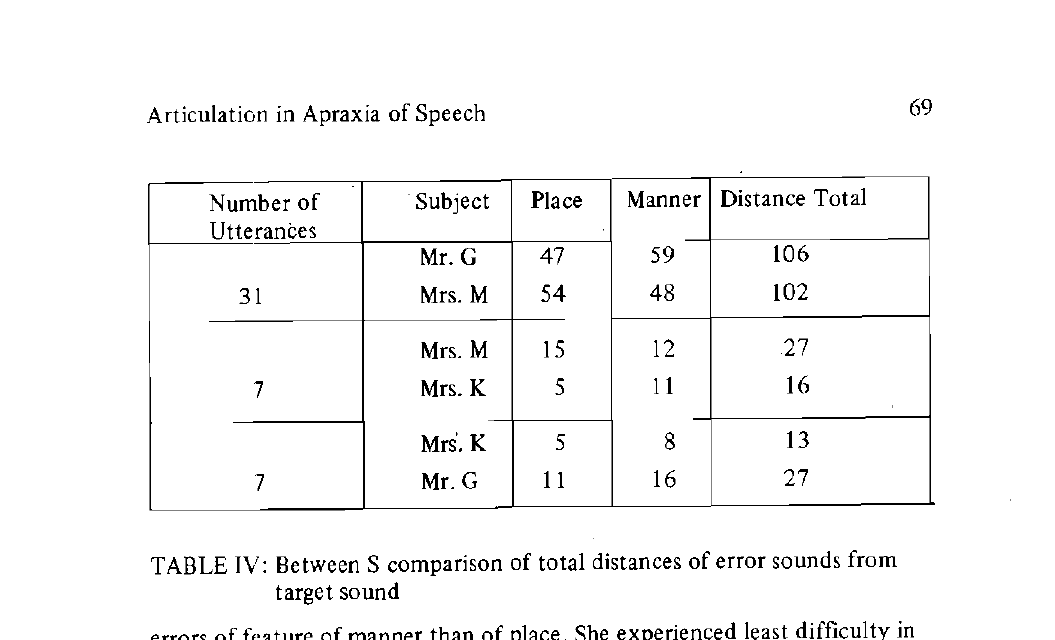
TABLE IV: Between S comparison of total distances of error sounds from target sound